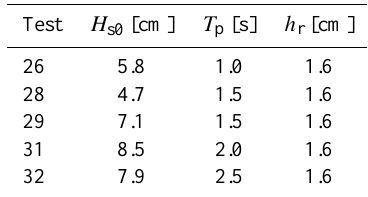
Fig. 2. Cross-reef bathymetry and wave gauge locations in the lab- oratory experiments by Demirbilek et al. (2007). Table 2. Simulated cases from Demirbilek et al. (2007).